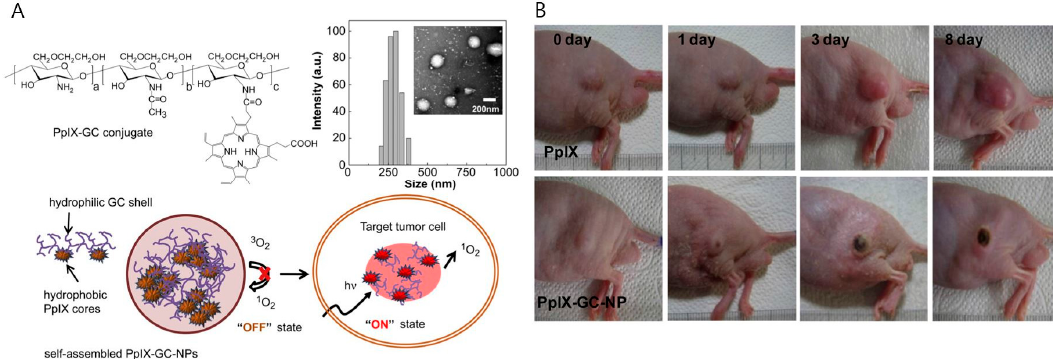
Figure 9. ( A ) Chemical structure and schematic diagram of protoporphyrin IX (PpIX)-conjugated glycol chitosan nanoparticles for photodynamic therapy (PDT)therapy; ( B ) result of in vivo PDT therapy by PpIX-conjugated glycol chitosan nanoparticles, compared with that of free PpIX (Adapted with permission from [76]. Copyright 2011 Elsevier Ltd.)